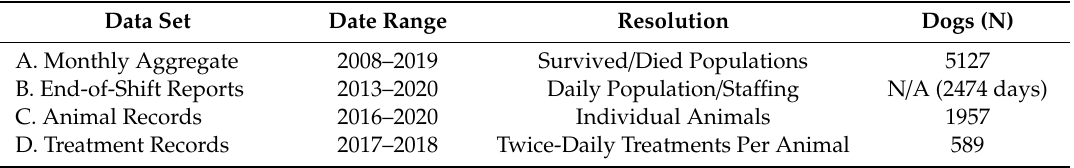
Table 1. The data sets, time ranges, and temporal resolutions for the four data sets examined in this study.